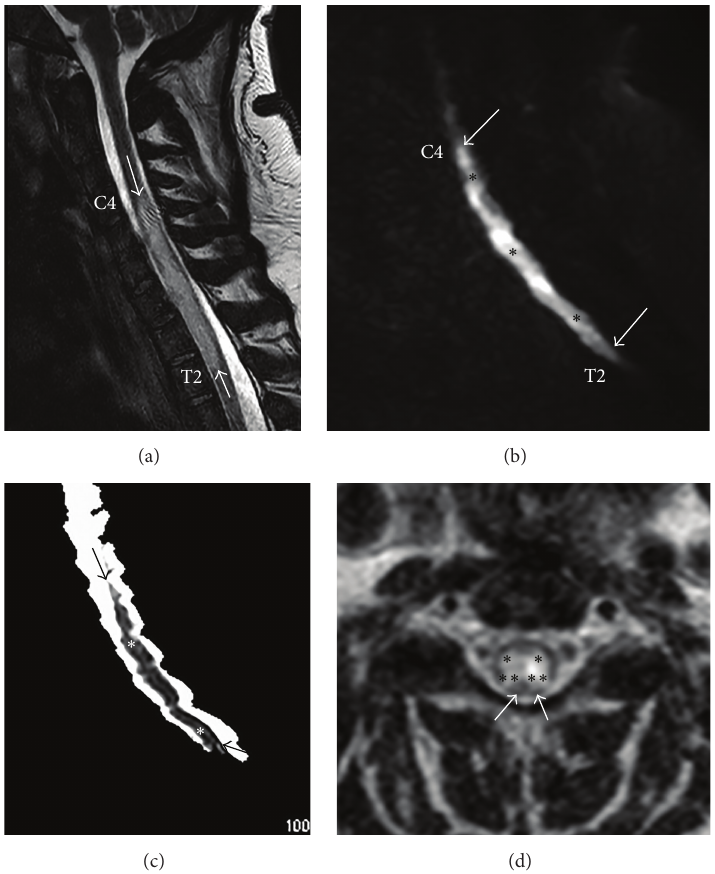
Figure 2: (a) Sagittal T2 weighted Fast Spin echo (FSE) MR image shows spinal cord expansion (swelling) with abnormal increased T2 signal extending from the C4 level to the T2 level (between the white arrows). (b) Sagittal DWI trace image shows abnormal increased signal intensity between C4 and T2, corresponding to the abnormal T2 signal noted on Sagittal T2 FSE imaging. (c) Sagittal apparent diffusion coefficient (ADC) map shows abnormal restriction of diffusion (dark signal in spinal cord indicated by arrows and asterisks) indicating that the increased signal on the DWI trace image represents diffusion restriction (not T2 shine through). (d) Axial T2 weighted FSE image at the C4 level shows cord expansion (swelling) and abnormal increased T2 signal within the swollen, edematous central gray matter (single asterisks indicate anterior horns and double asterisks indicate posterior horns of central gray matter). White arrows indicate uninvolved dorsal columns of the spinal